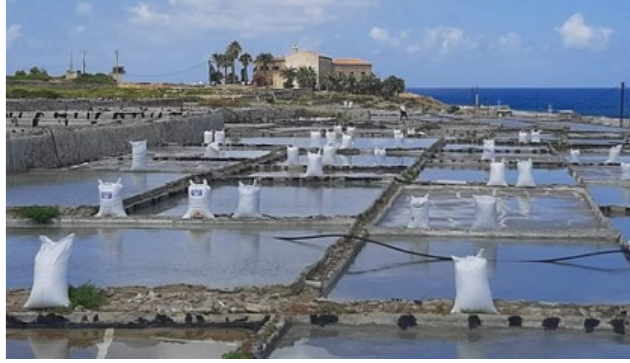
Figure 4. Organic and artisanal MP-free sea salt production.